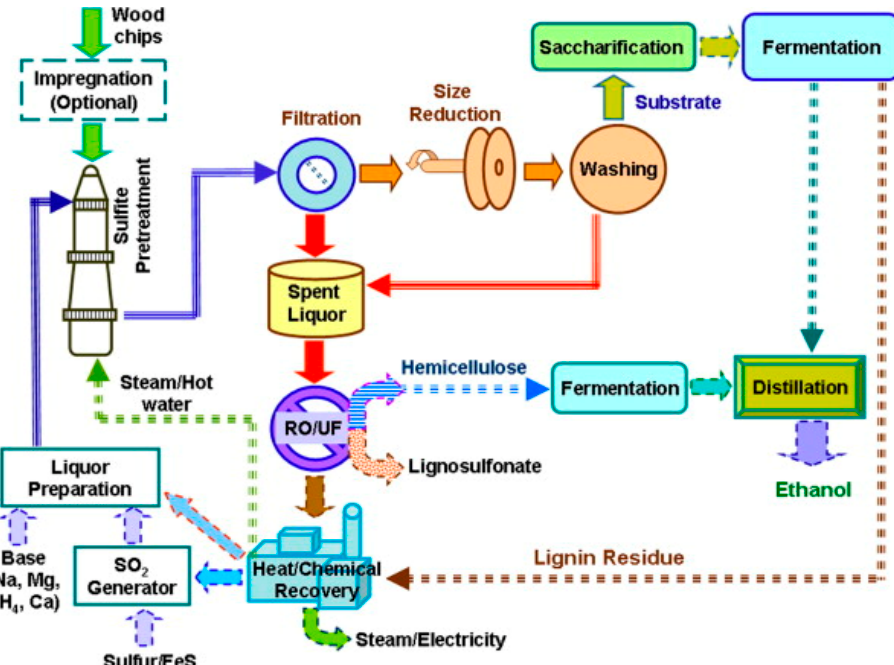
Figure 6. Schematic process flow diagram of the sulfite pretreatment [80]. Acid Sulfite